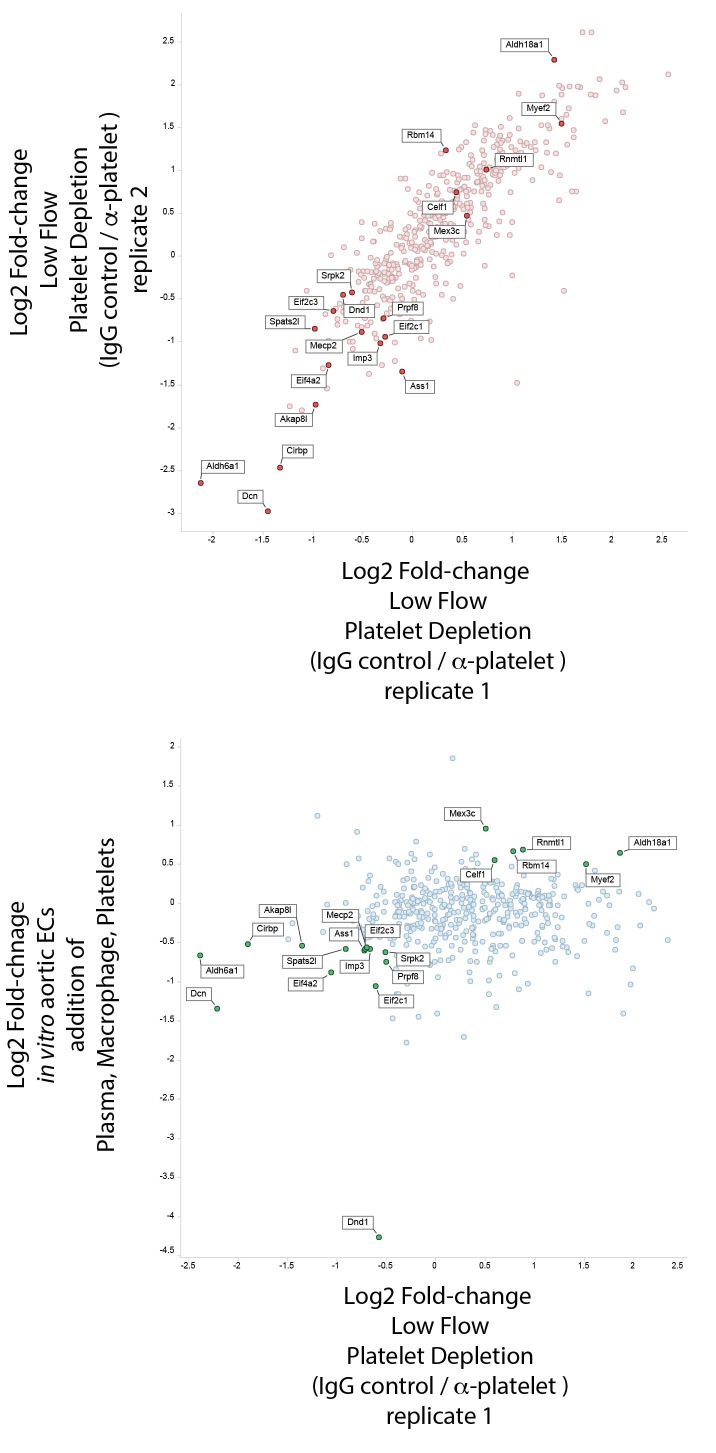
No obvious candidate splice factors from differential expression under altered flow conditions.Differential expression of RNA-binding proteins under conditions with altered splicing. Factors highlighted had consistent differences of <−0.5 or >0.5 in both sets of data. Only Dcn (decorin) showed differences of <-1 in both. RNA-binding proteins with FPKM <0.5 in the in vivo data sets were filtered out.